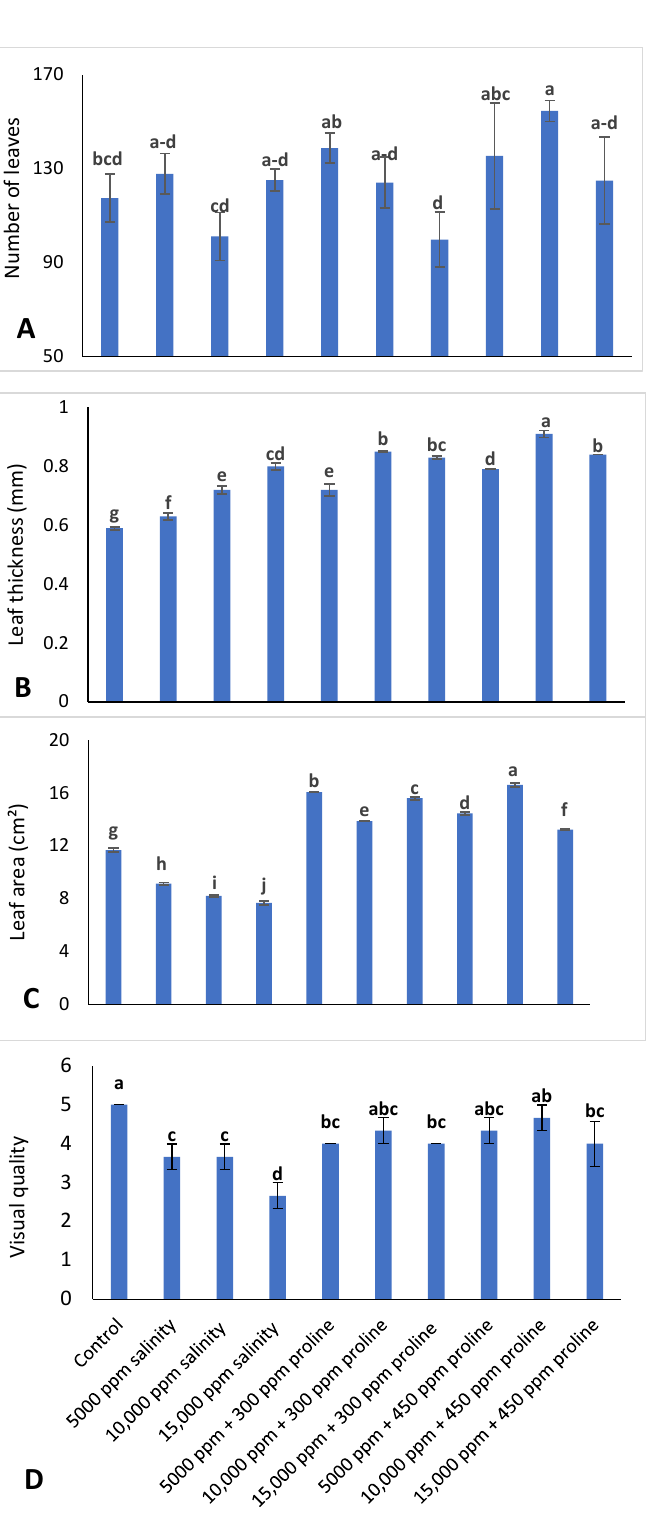
Figure 3. Effect of different levels of seawater salinity and exogenous proline at three concentrations, 0 ppm, 300 ppm, and 450 ppm, on number of leaves ( A ), leaf thickness (mm) ( B ), leaf area (cm 2 ) ( C ), and visual quality ( D ). Data are means of two seasons (2020 and 2021) and three replicates ( n = 3) for each season. The mean values ± SE of each parameter followed by different alphabetical letters are significantly different according to Duncan’s multiple range test at p ≤ 0.05.